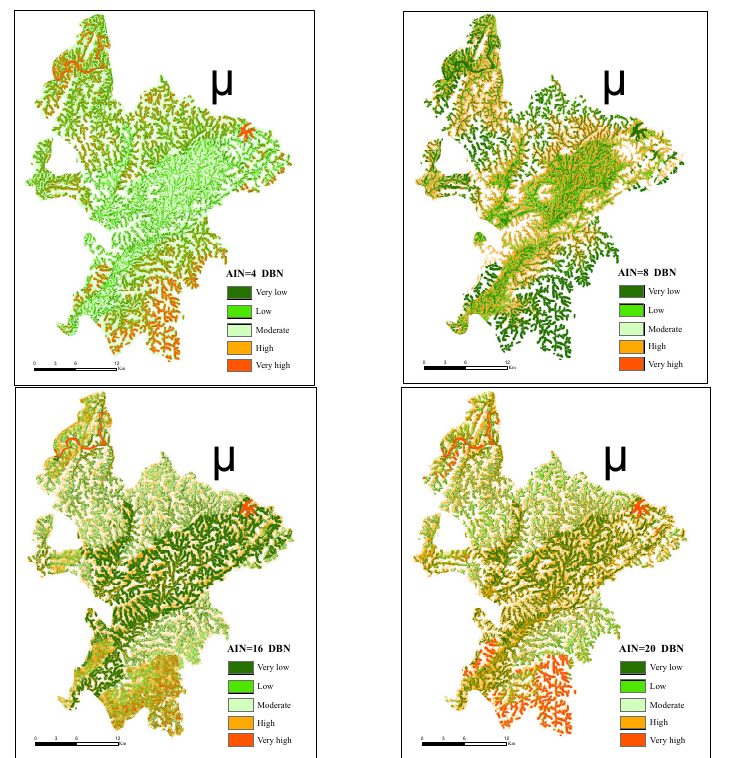
Figure 6. Landslide susceptibility maps of di ff erent AINs and DBN models.